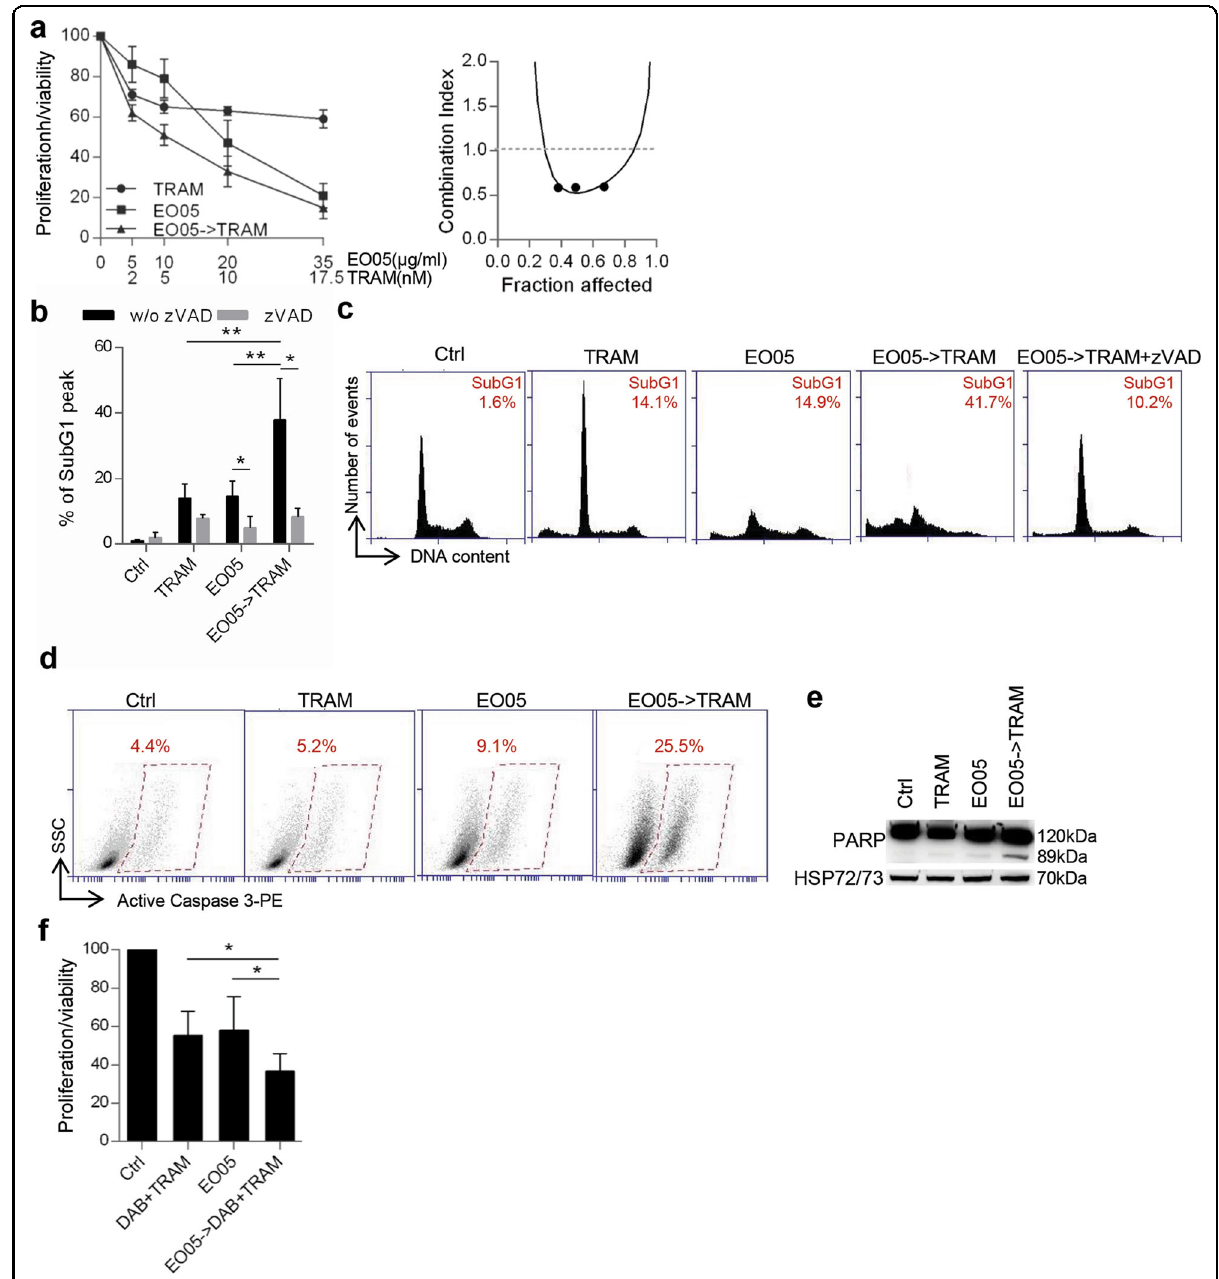
Fig. 4 EO05 sensitizes M14 melanoma cells to trametinib treatment. a Analysis of cell proliferation/viability by MTT assay (left) and relative isobologram (right) of M14 cells treated with 48 h trametinib (TRAM) or 24 h EO05 alone or 24 h EO05 followed by 48 h trametinib (EO05- > TRAM). b Quanti fi cation and c representative images relative of subG1 peak by propidium iodide staining of M14 cells control (Ctrl) or treated with TRAM (48 h, 10 nM), EO05 (24 h, 20 μ g/ml) or with 24 h EO05 followed by 48 h TRAM (EO05- > TRAM), in the presence or absence of zVAD (50 μ M). The percentage of cells in the subG1 peak is reported. d Flow cytometric analysis of active caspase 3-PE staining in cells treated with TRAM (48 h, 10 nM), EO05 (24 h, 20 μ g/ml), or with 24 h EO05 followed by 48 h TRAM (EO05- > TRAM). e Western blot analysis of PARP cleavage in M14 cells treated as reported in d . HSP72/73 was used as loading and transferring control. Western blot representative of two blots with similar results is shown. f MTT assay of M14 cells treated with dabrafenib (0.001 μ M) + trametinib (0.1 nM) for 48 h, EO05 (20 μ g/ml) for 24 h alone or 24 h EO05 followed by 48 h DAB + TRAM (EO05- > DAB + TRAM). a , f The results are reported as “ cell proliferation-viability of treated cells/cell proliferation-viability of control cells × 100 ” . a , b , f The results represent the average ± standard deviation of three independent experiments. Experiments with zVAD were repeated twice. b , f p -values were calculated between cells treated in combination and cells treated with single drugs, or between cells treated or not treated with zVAD. * p < 0.05; ** p < 0.01 after applying Student ’ s t